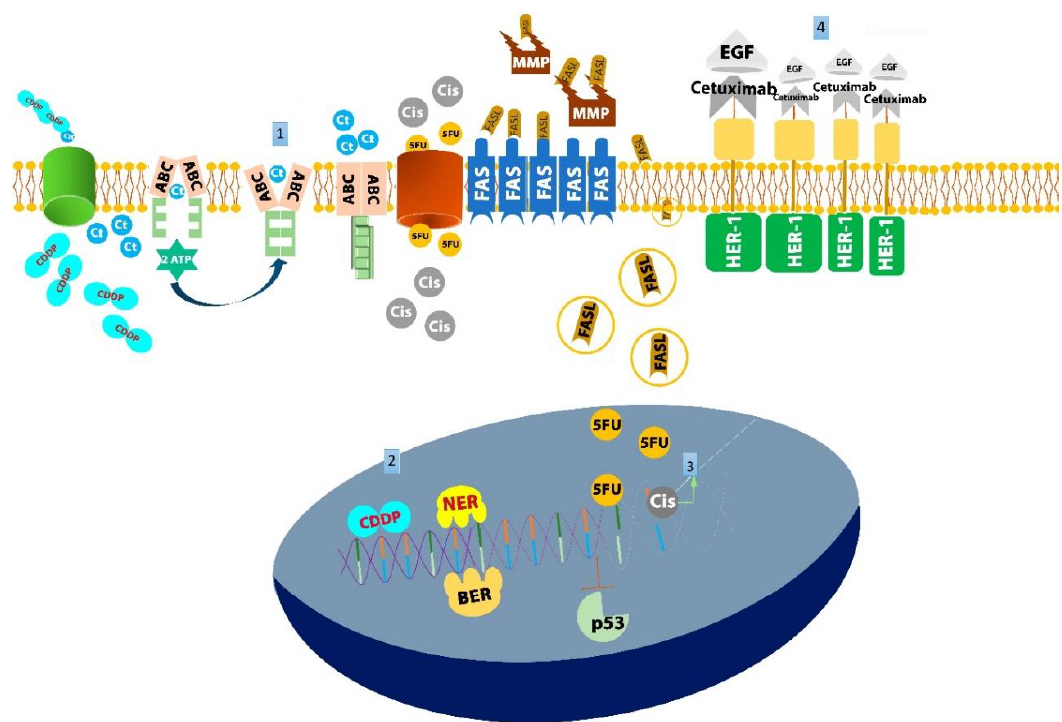
Figure 1. The principal molecular markers according to drug resistance mechanism-based groups in head and neck squamous cell carcinomas (HNSCCs). ( 1 ) Reduced concentration of antineoplastic drugs in cancerous cells. The family of ATP-binding cassette (ABC) transporters mostly includes P-glycoproteins (P-gp), which intracellularly bind to cytostatic agents and promote their exocytosis via ATP hydrolysis and conformational changes in the protein. Extracellularly, alterations in plasma membrane proteins may also decrease drug permeability. Expression or overexpression of the ABC genes encoding MDR1 , MRP1 , MRP2 , and BCRP is involved in oral squamous cell carcinoma (OSCC) chemotherapeutic resistance. ( 2 ) Increased DNA reparation ability of tumor cells. An increase in the tolerance to DNA damage because of highly efficient DNA repair machinery may be caused by the gene encoding components of the nucleotide excision repair and base excision repair (NER and BER) complexes. Polymorphisms in DNA repair genes may be used for predicting favorable clinical results in patients with HNSCC. ( 3 ) Enhanced tumor survival and routes of dissemination. FasL is upregulated in cells treated with cisplatin and 5-FU, which induce programmed cell death. Alterations in the gene encoding p53 silence matrix metalloproteinases (MMPs) overexpression, which has been associated with the survival and dissemination of tumors and drug resistance. ( 4 ) Inactivation of antineoplastic drugs. Increasing evidence suggests that EGFR ligands influence the response to EGFR-targeted therapy and might be useful as predictive biomarkers. The autocrine growth factor production might compete with blocking antibodies for binding to EGFR and thereby reduce their effectiveness.